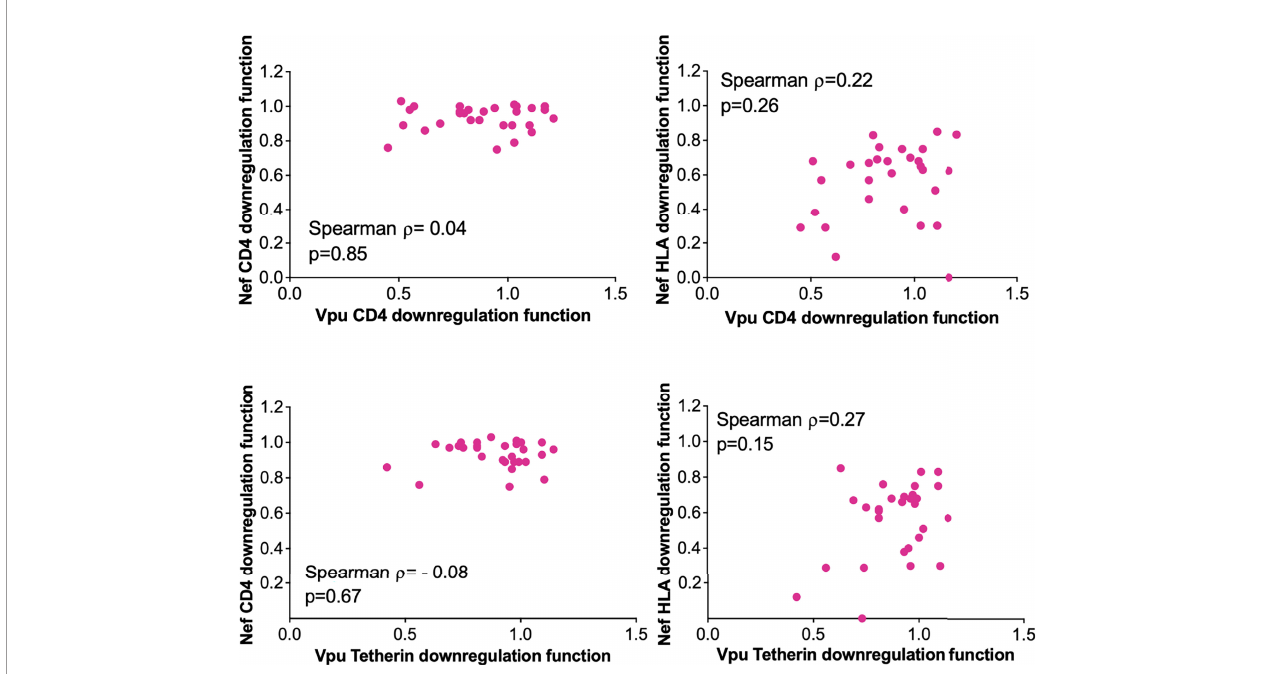
FIGURE 5 | Relationship between within-host Nef and Vpu functions in the survivor cohort. Relationships are assessed using Spearman ’ s